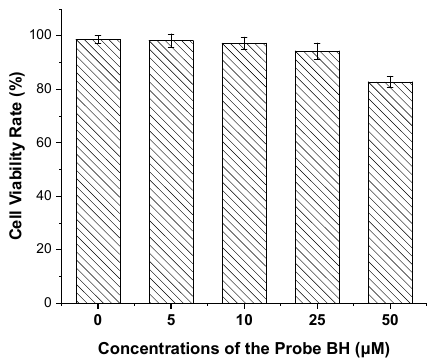
Molecules 2022 , 27 , x FOR PEER REVIEW Figure 5. Cell viability values (%) estimated by an MTT assay versus incubation concentrations of CT26 cells were cultured in the presence of probe (0–50 μM) at 37 °C for 48 h.